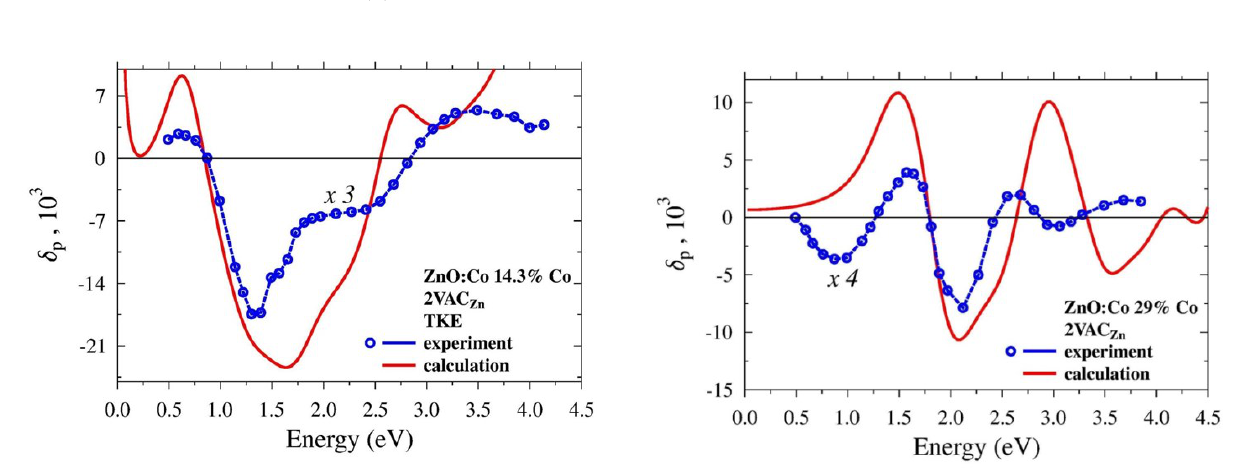
Fig. 3. Calculated (red line) and experimental (blue circles + broken line [1]) TKE in ZnO:Co for two Co concentration Left panel - 14% Co, right panel – 28%